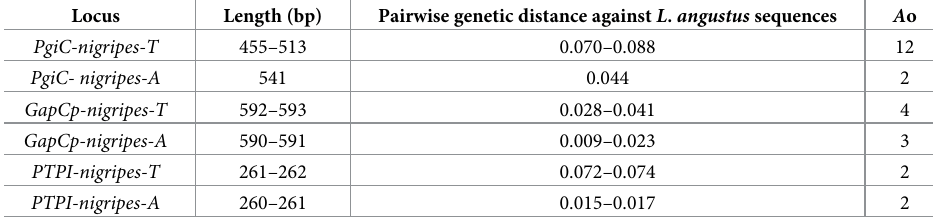
Table 3. The length of sequences obtained from Lepisorus nigripes , pairwise genetic distances compared to L . angustus sequences, and observed number of alleles ( A o) at each